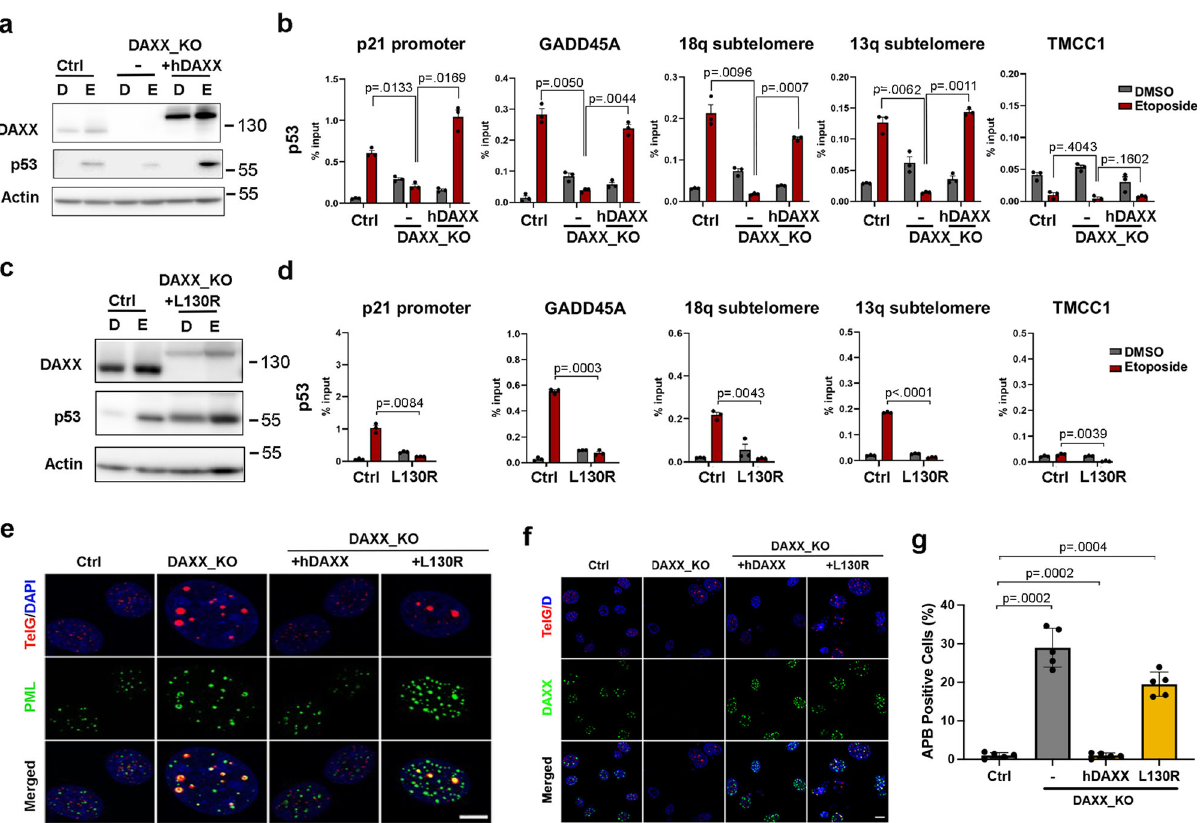
Fig. 6 | DAXX dependency for p53 function in DAXX_KO U87-T cells. a Western blotofControl(Ctrl),DAXX_KO,orDAXX_KO+hDAXXcellstreatedwithDMSO(D) or 50 μ M etoposide (E) and probed with antibody to DAXX, p53, or actin. b p53 ChIP-qPCRforcellstreatedasinpanel a .Errorbarsindicatestandarddeviationand P values determined by two-tailed student t test for three biological replicates. c Western blot of Ctrl or DAXX_KO+L130R cells treated with DMSO (D) or etopo- side(E)andprobedwithantibodytoDAXX,p53,oractin. d p53ChIP-qPCRforcells treated as in panel c . Error bars indicate standard deviation and P values